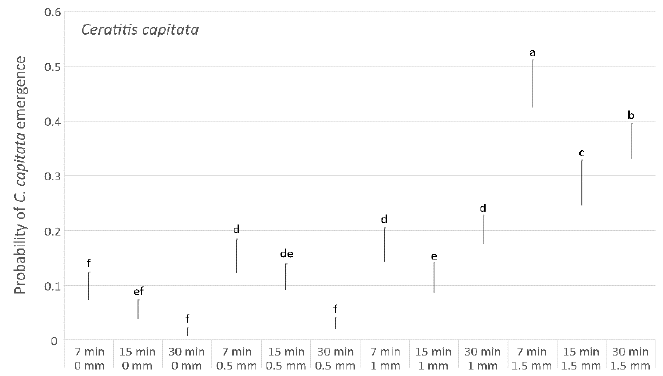
Figure 6. Differences in the probability of C. capitata adults emergence in tests performed with different exposition distances and time. Different letters indicate significant differences (Bonferroni multiple comparisons test). Insects 2019 , 10 , x FOR PEER REVIEW Figure 7. Differences in the probability of not emergence in tests performed with different exposition distances and time. Different letters indicate significant differences (Bonferroni multiple comparisons test).